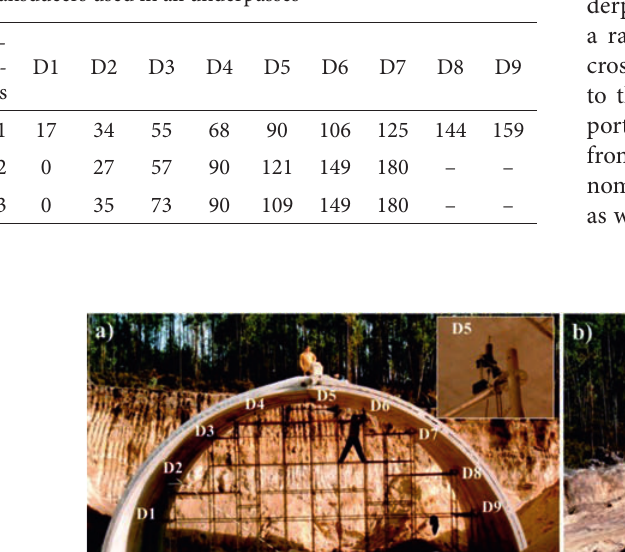
Table 1. Angular position ( q in degrees, c.f. Fig. 3) of transducers used in all underpasses